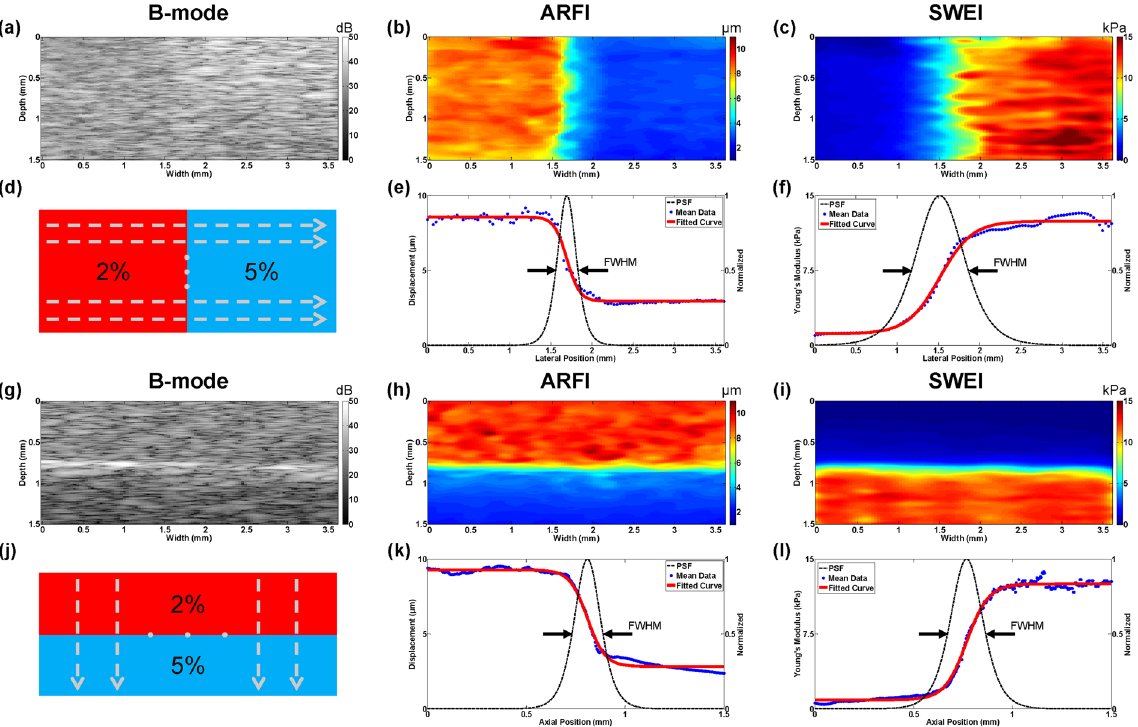
Figure 2. Bi-layer phantom imaging results and its corresponding FWHM resolution. 2D cross-sectional B-mode image, ARFI image and SWEI image. ( a – c ) Left-right phantom with a vertical boundary at a width of 1.6 mm; ( g – i ) Up-down phantom with a horizontal boundary at a depth of 0.8 mm; ( d , j ) Schematic diagram of uniformly selected curve profiles, N = 20 for both Left-right phantom and Up-down phantom; Lateral FWHM resolution model of ( e ) ARFI image and ( f ) SWEI image; Axial FWHM resolution model of ( k ) ARFI image and ( l ) SWEI